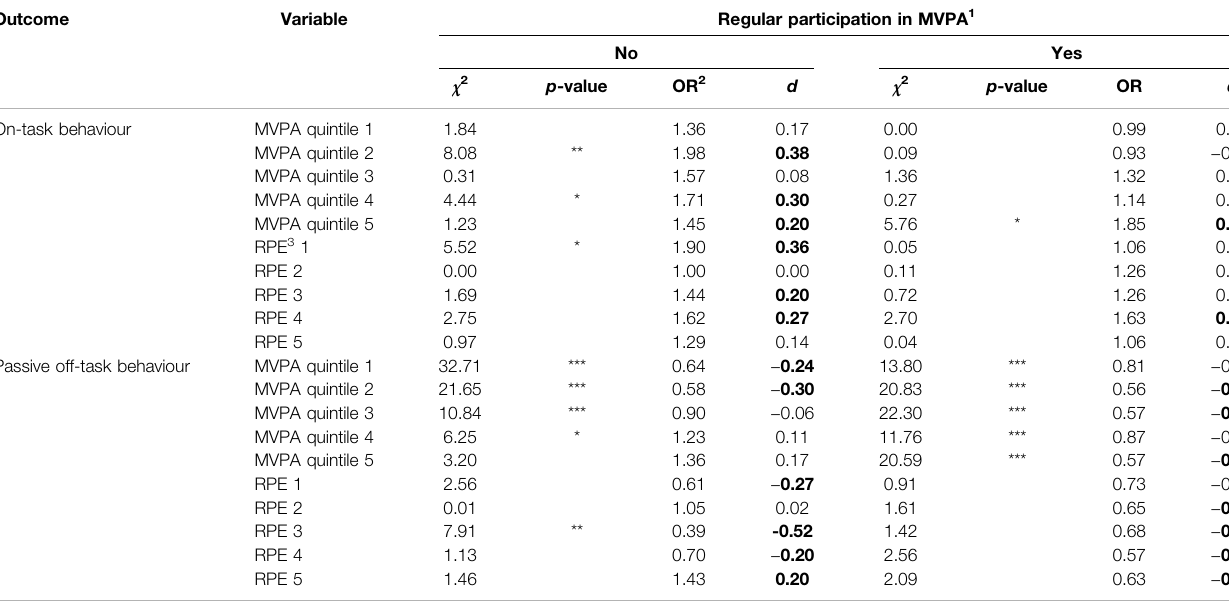
TABLE 8 | Response of task-behaviour to objective and subjective PA by regular moderate-to-vigorous physical activity.